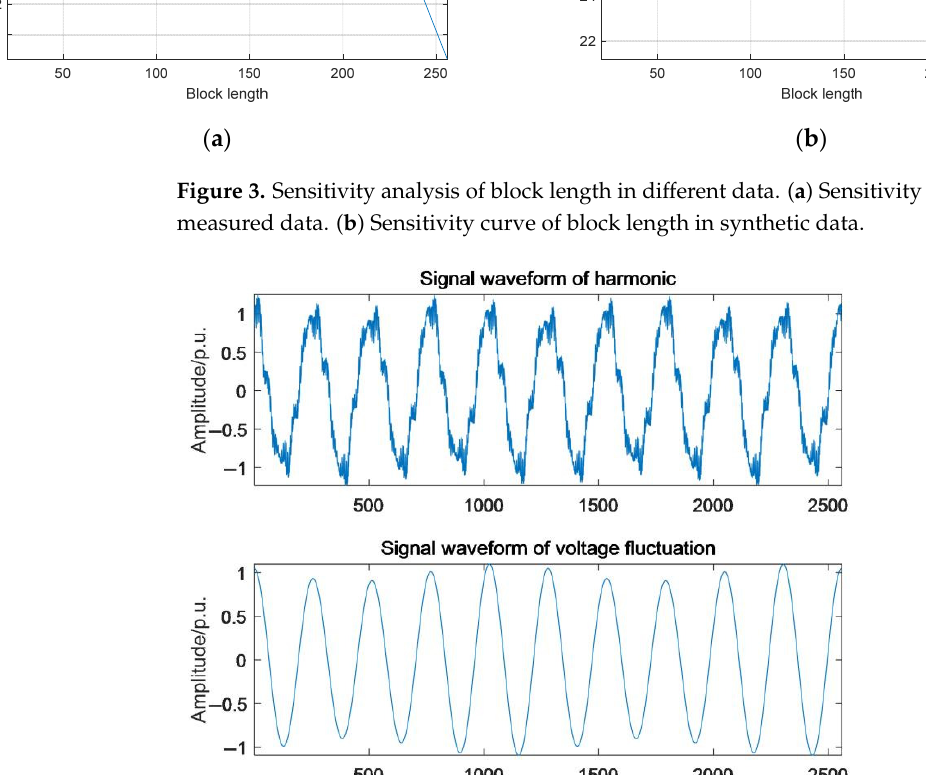
Figure 4. Signal waveform of harmonic and voltage fluctuation. For harmonic signals and voltage fluctuation signals, the DFT and DCT were used to perform sparse transformations and then compressed and reconstructed. The coefficients in the DFT and DCT domains are shown in Figures 5 and 6, respectively.